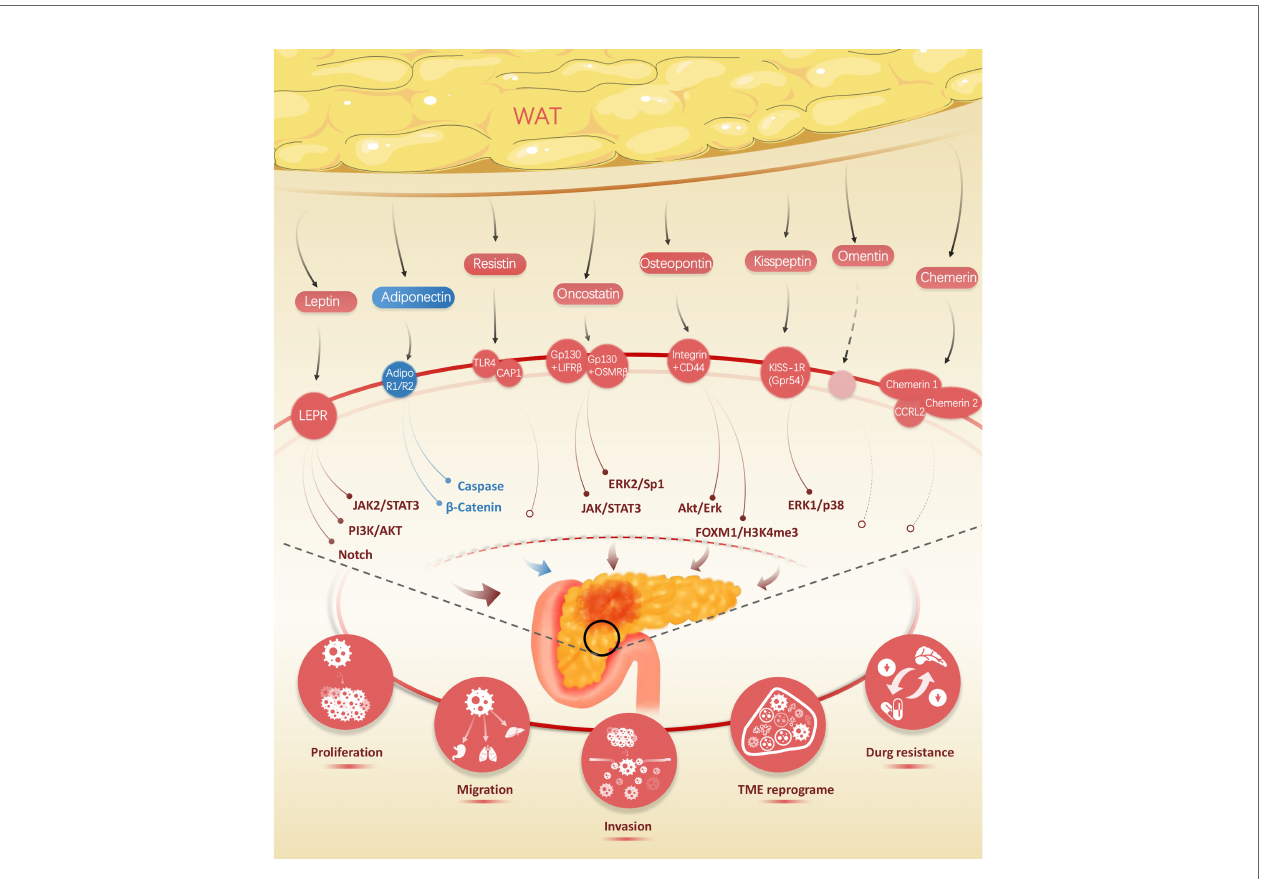
FIGURE 1 | Wide range of adipokines released by white adipose tissue, including leptin, adiponectin, resistin, oncostatin, kisspeptin, omentin, and chemerin, impact on the biological traits of pancreatic